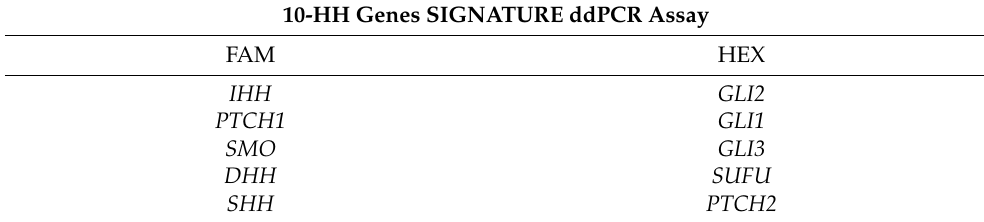
Table 3. ddPCR multiplexed assay validation of a 10 HH gene signature. The different assays have been multiplexed in order to optimize the cartridge by coupling genes with similar values of expression in the same well. SMO, SHH, PTCH1, IHH, DHH, and MTBP were conjugated with FAM fluorophores, whereas SUFU, GLI1, GLI2, GLI3, and PTCH2 were conjugated with HEX fluorophores. 10-HH Genes SIGNATURE ddPCR Assay FAM HEX IHH GLI2 PTCH1 GLI1 SMO GLI3 DHH SUFU SHH